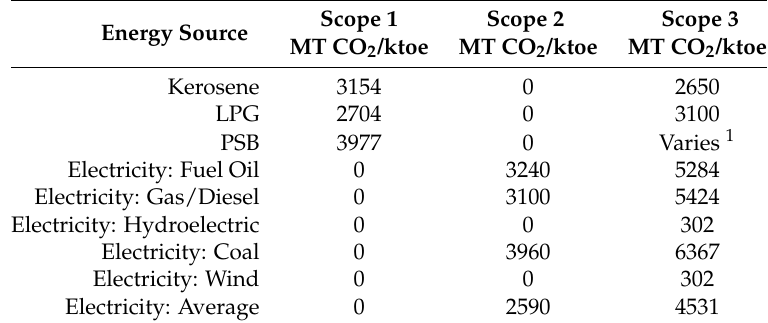
Table 2. Scope 1, 2, and 3 Emissions Factors for Kerosene, LPG, PSB, Fuel Oil, Gas/Diesel, Hydroelectric, Coal, Wind, and Electricity (Average). Scope Energy Source